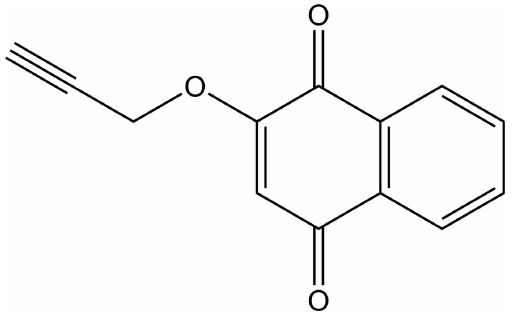
Table 1 Hydrogen-bond geometry (A˚ , (cid:4)